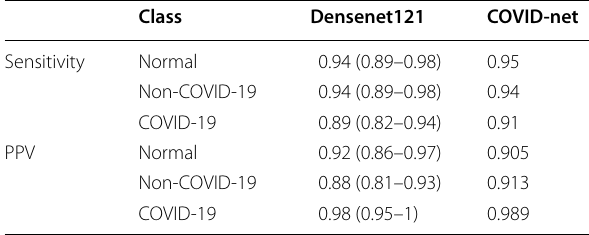
Values in parenthesis are 95% confidence intervals obtained using 2000 bootstrap